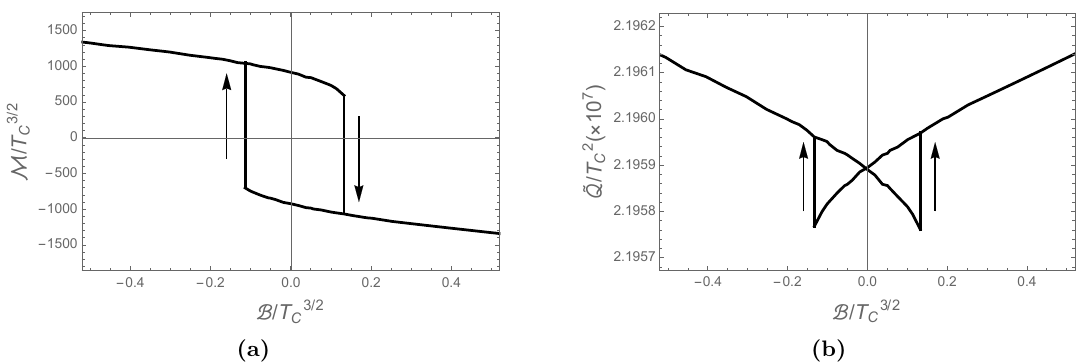
Figure 4 . (a) Hysteresis curve of the magnetization. (b) Hysteresis curve of the charge